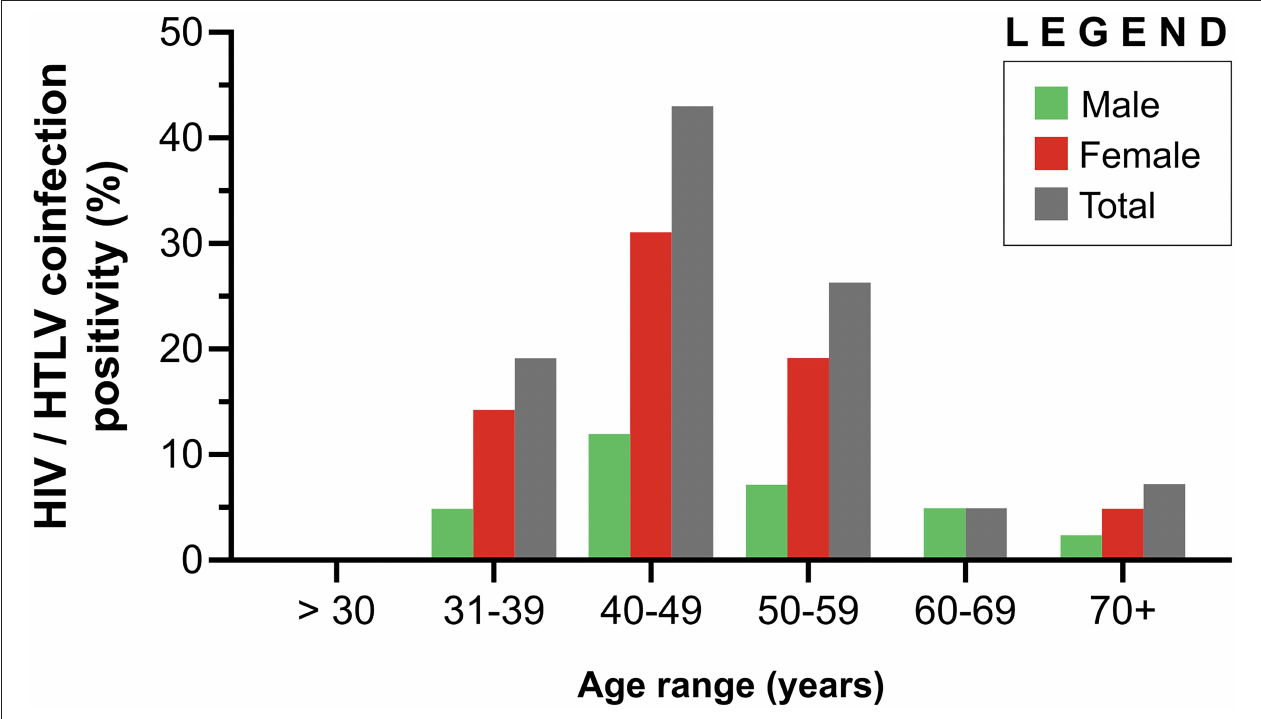
FIGURE 3 | Distribution of HIV/HTLV coinfection according to age among 29 females and 13 males in Bahia, Brazil (2004–2013).